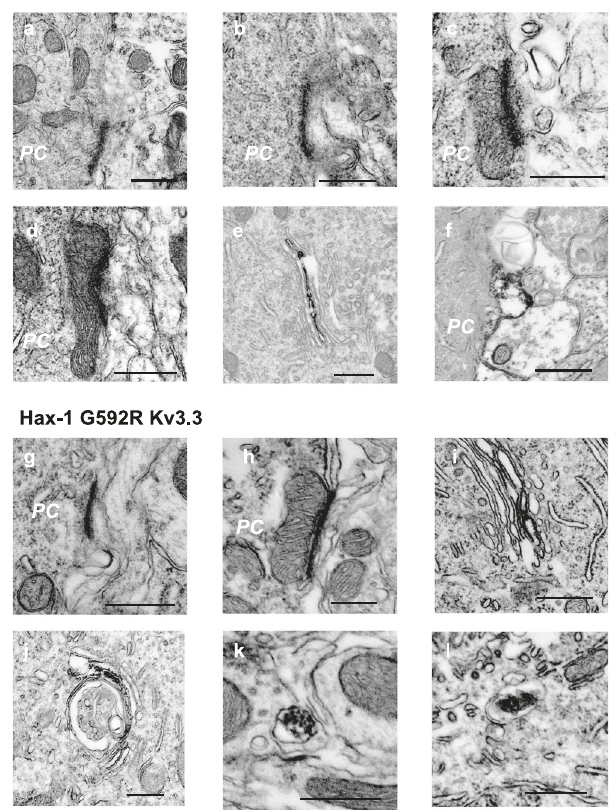
Fig. 8 Electron immunomicroscopic localization of Hax-1 in Purkinje cells (PC) using diaminobenzidine labeling to localize immunoreactivity. a , b Immunostaining detected at the plasma membrane of wild-type animals. c , d Hax-1 immunoreactivity at sites where mitochondria are apposed to the plasma membrane in wild-type animals. e Hax-1 on endoplasmic reticulum (wild-type mice). f Hax-1-immunoreactive protrusions at the soma of a neuron from a wild-type animal. g Hax-1 at the plasma membrane in G592R Kv3.3 mice. h Mitochondrial/plasma membrane Hax-1 immunoreactivity in G592R Kv3.3 mice. i and j Hax-1 on endoplasmic reticulum in G592R Kv3.3 mice. k and l Examples of multivesicular bodies with internal